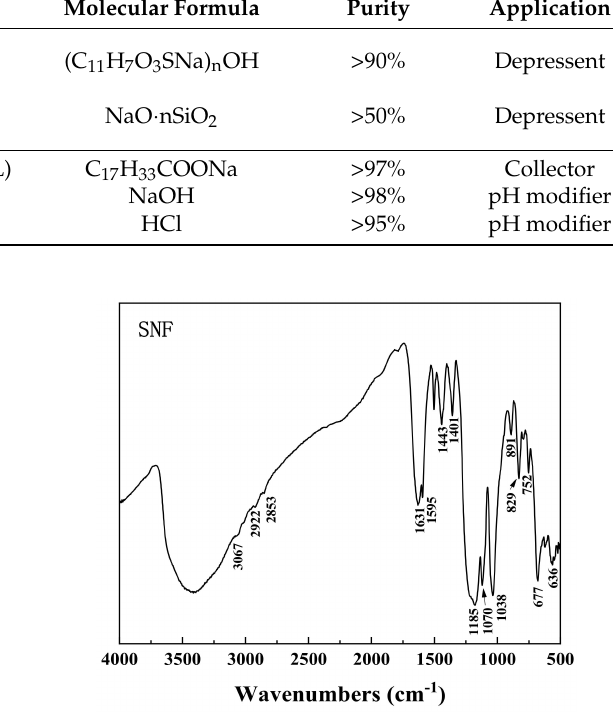
Figure 3. FTIR spectra of the SNF